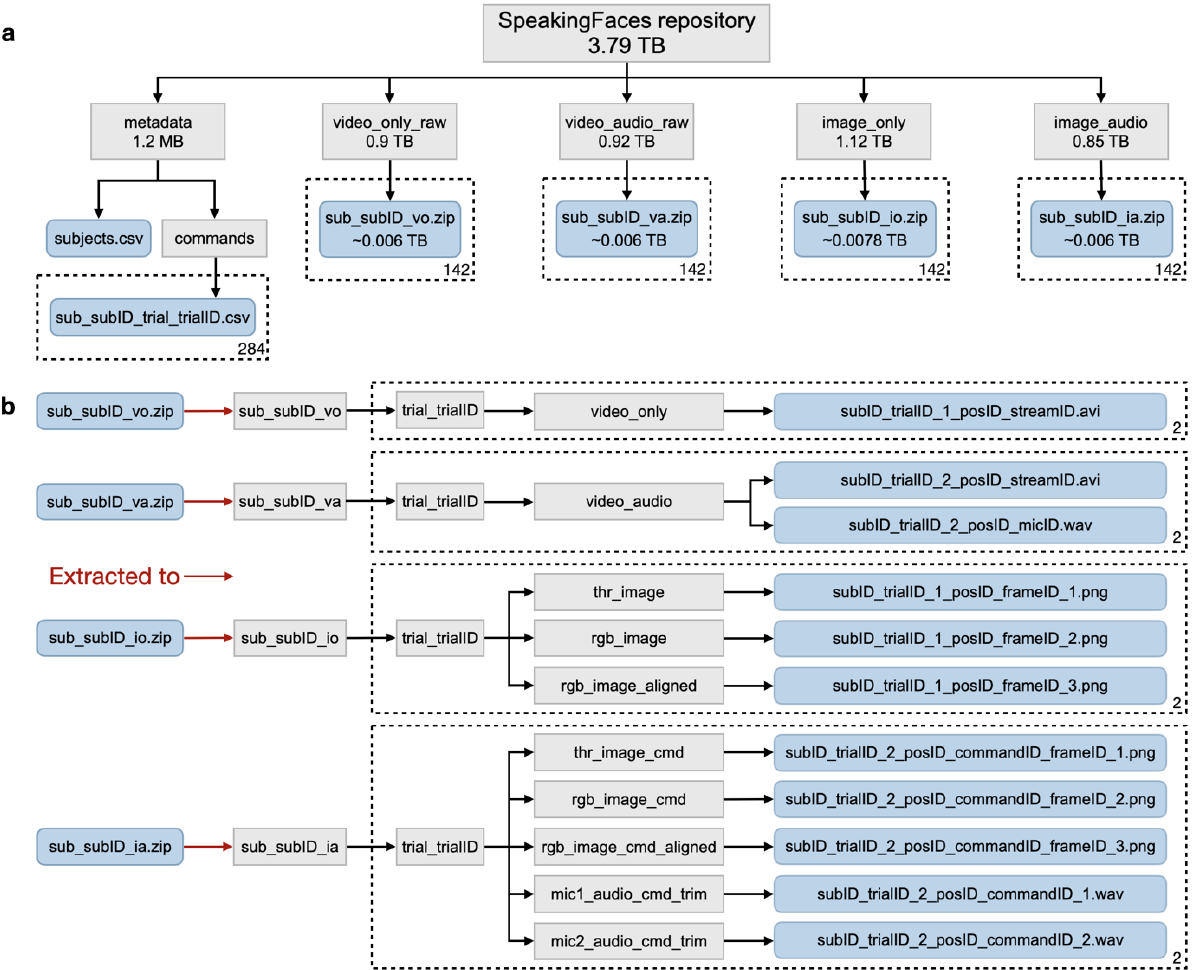
Figure 7. ( a ) File structure of SpeakingFaces repository. File names are suffixed by subID = { 1, . . . ,142 } and trialID = { 1,2 } , bringing the total number of files to the indicated max (142 or 284). ( b ) Illustration of the extrac- tion procedure for the archived files in the SpeakingFaces repository and the final output files for each type. Directories are shaded gray, and the files are shaded blue for both